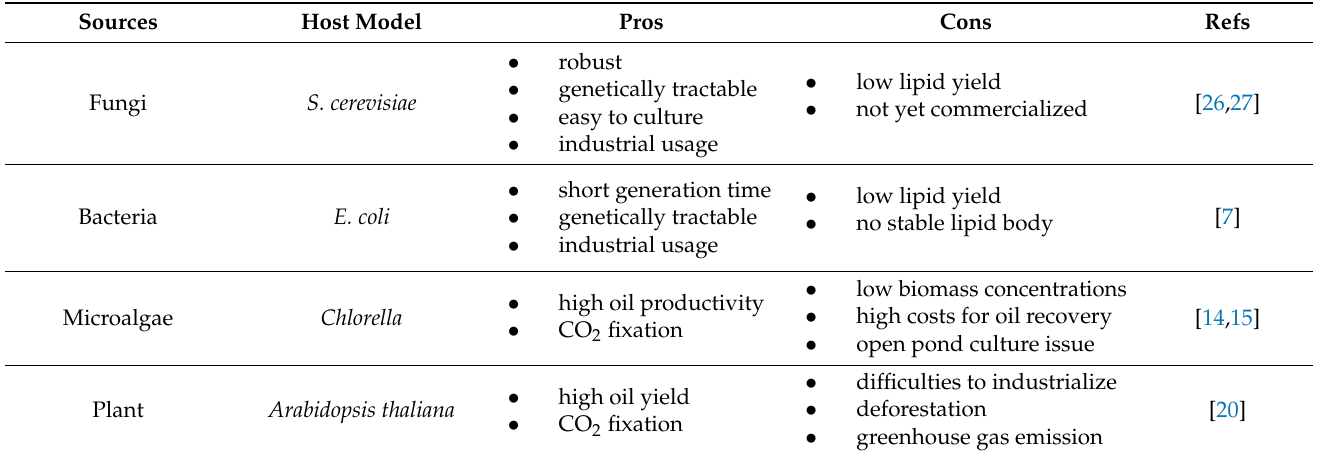
Table 1. Comparison of different hosts for lipid